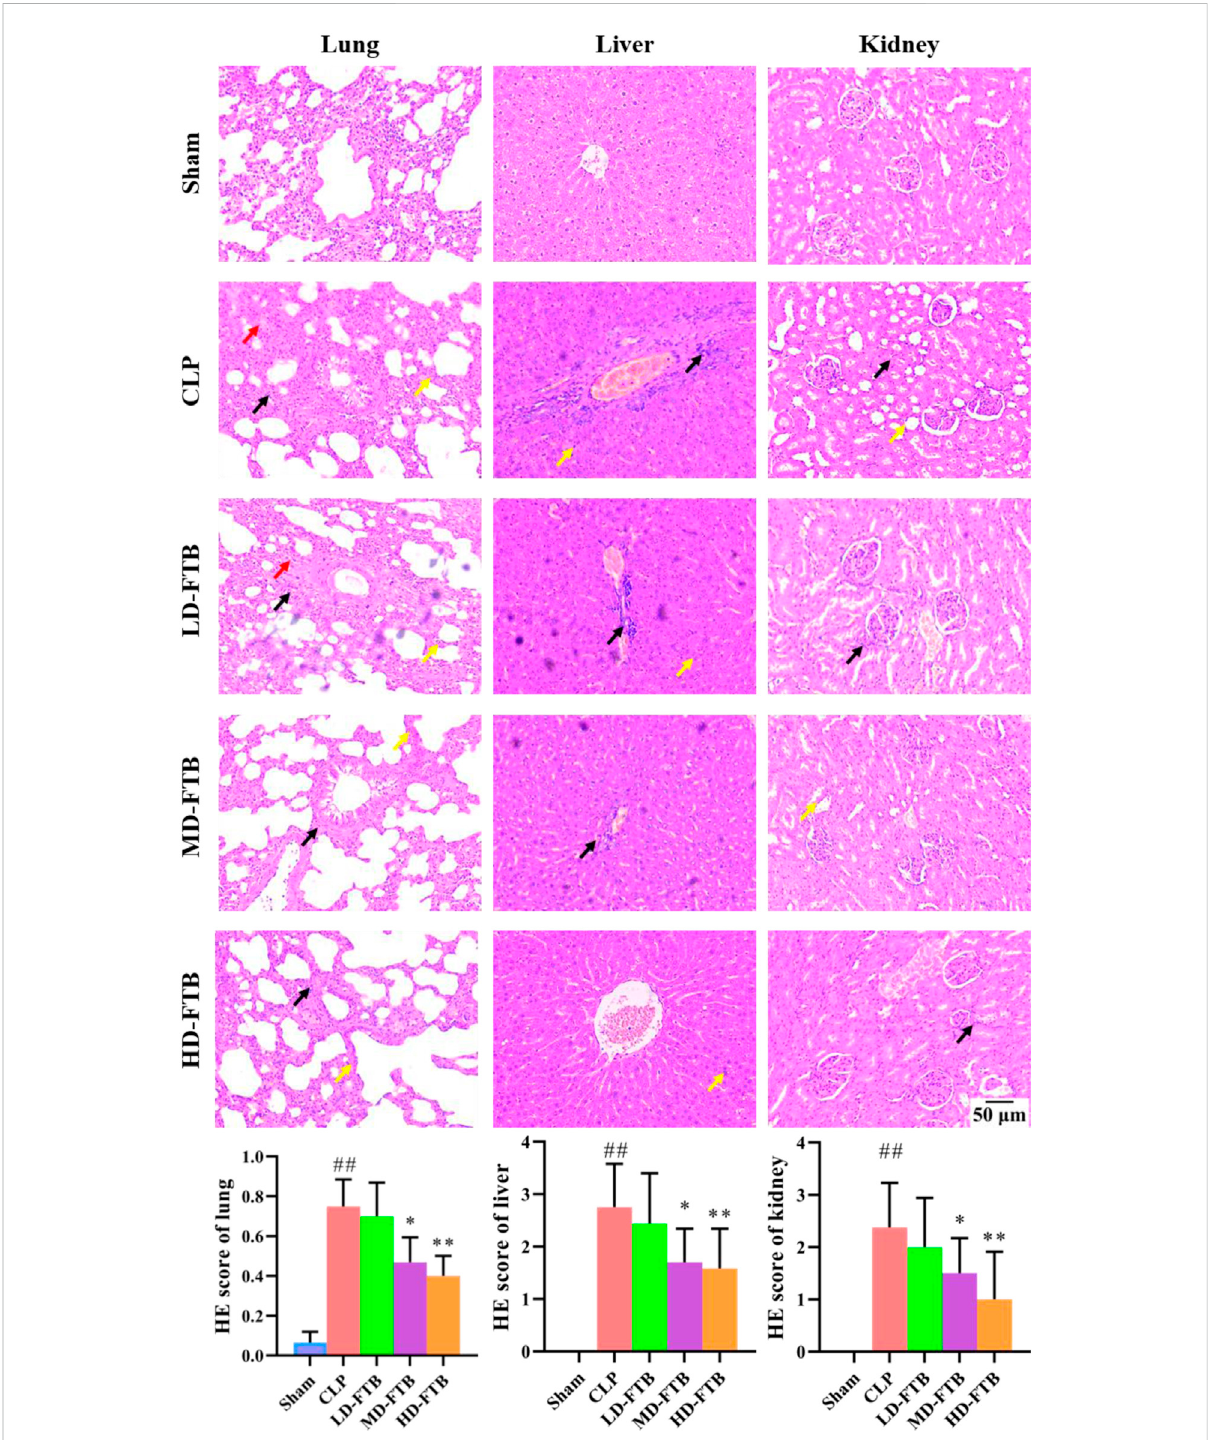
FIGURE 3 Effects ofFTBonCLP-inducedpathological changesand tissueinjury scores ofthelung,liver andkidneyinrats. TheCLP-induced pathological changes in lung, liver and kidney after treatment with FTB were observed and the tissue injury scores were evaluated by HE staining. Treatment with FTB improved the CLP-induced pathological changes in the lung (red arrows indicate the pulmonary interstitial congestion, yellow arrows indicate the thickened alveolar walls and black arrows indicate the in fi ltration of in fl ammatory cells), liver (yellow arrows indicate the necrotic hepatocytes and black arrows indicate the in fi ltration of in fl ammatory cells) and kidney (yellow arrows indicate the enlarged lumen of focal tubules and black arrows indicate the interstitial in fl ammatory cell in fi ltration), and decreased the tissue injury scores (magni fi cation: ×100). Sham ( n = 15), CLP ( n = 8), LD-FTB ( n = 9), MD-FTB ( n = 10), HD-FTB ( n =